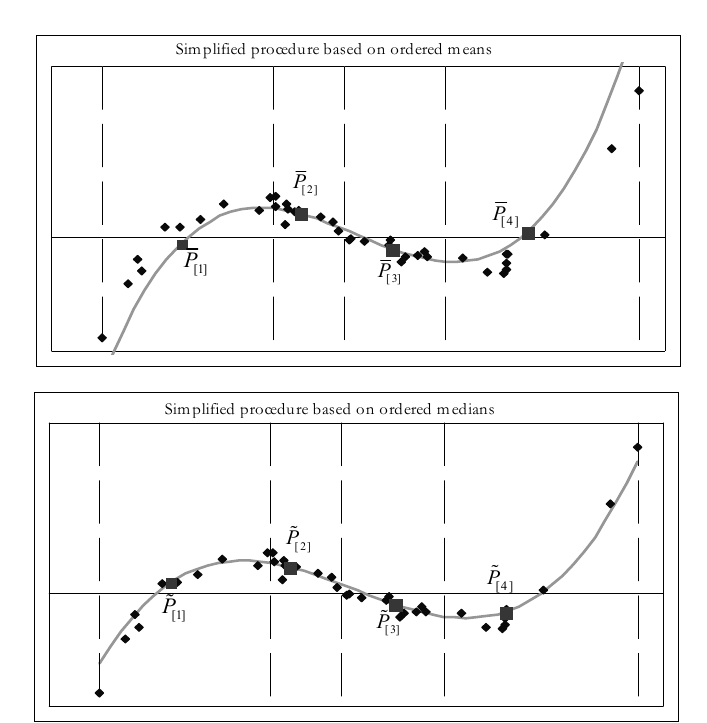
Figure 1 – The proposed simplified procedure: an example for n = 30, m = 4, r =